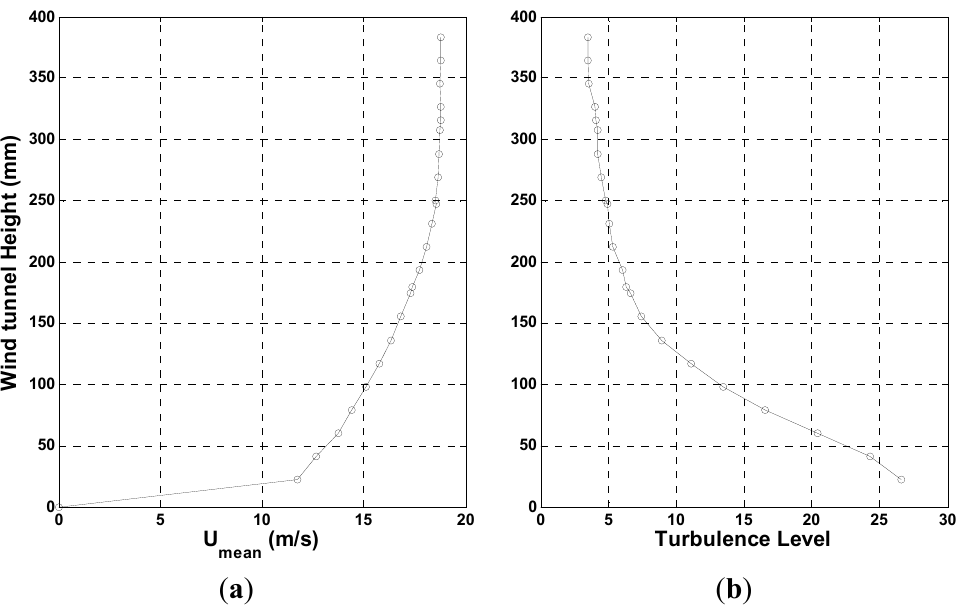
Figure 1. ( a ) Mean wind speed in m/s; and ( b ) turbulence level in